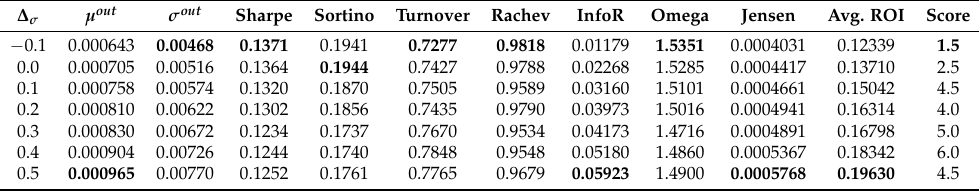
Table 7. EuroBonds: out-of-sample performance results for the RMZ R strategy by varying ∆ σ (with ∆ γ =